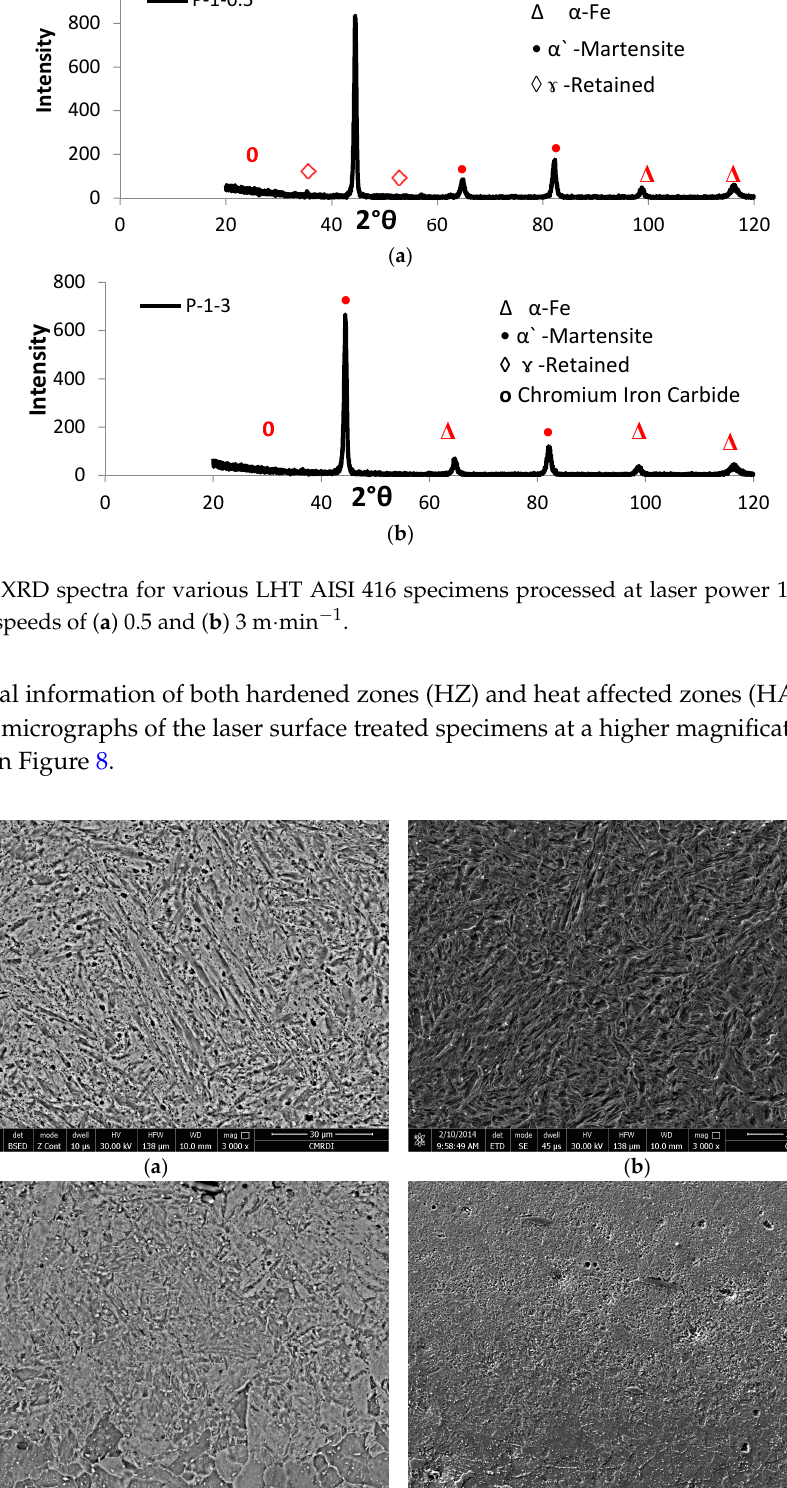
Figure 6. EDX analysis of the LHT P ‐ 1 ‐ 0.5 sample: ( a ) hardened zone (HZ); ( b ) heat affected zone (HAZ); and ( c ) base metal (BM).